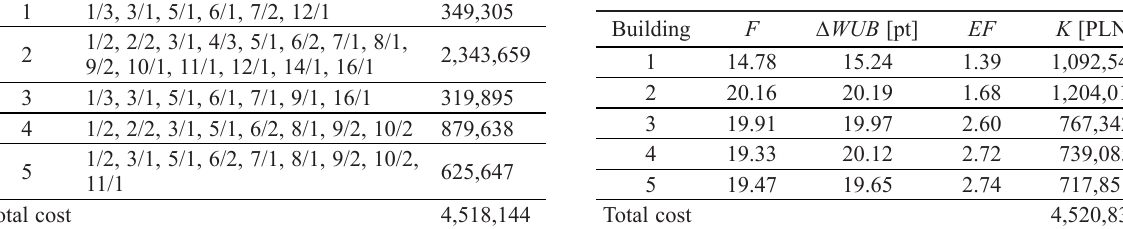
table 9. Repair solutions for 5